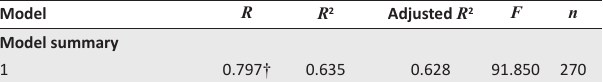
TABLE 4b: Regression analysis (all